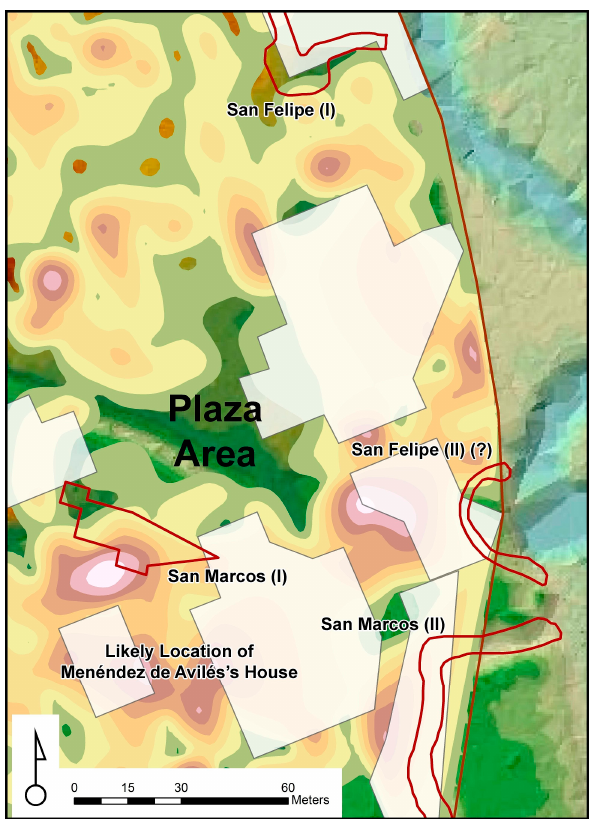
Figure 19. Map showing the spatial relationships between known Spanish forts, the plaza area, and the distribution of all Spanish artifacts. The legend for the distribution of Spanish artifacts is the same as that used in Figure 10. Areas whited-out were not shovel tested.